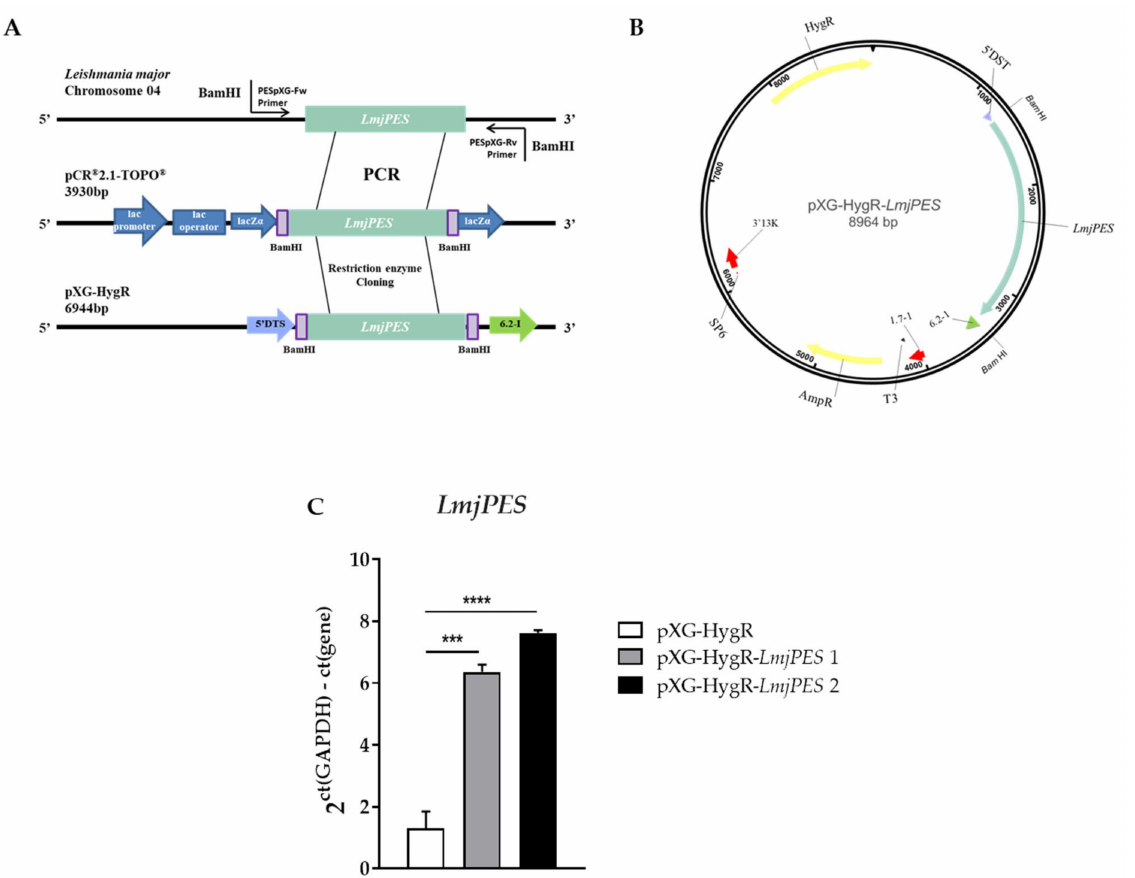
Figure 4. Generation of Leishmania major strains overexpressing LmjPES . (A) Schematic representation of the approach to clone LmjPES into the pXG-HygR overexpression plasmid. ( B ) Map of the episomal plasmid carrying the LmjPES sequence used to generate overexpressing parasites ( C ) LmjPES gene expression level of two LmjPES -overexpressing L. major strains (pXG-HygR- LmjPES1 and pXG-HygR- LmjPES2 ) compared to L. major control (pXG-HygR) parasites (*** p < 0.001; **** p <